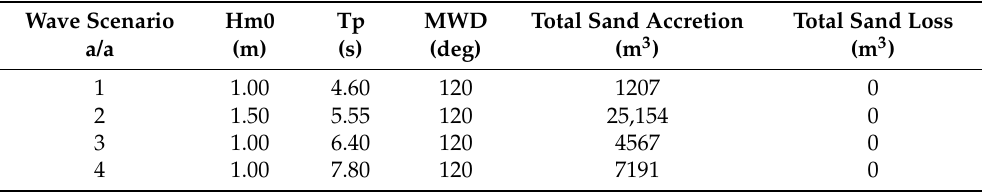
Table 4. Comparison of tombolo constructive wave scenario results of total volume of sand accretion and loss in the active area for tombolo formation.